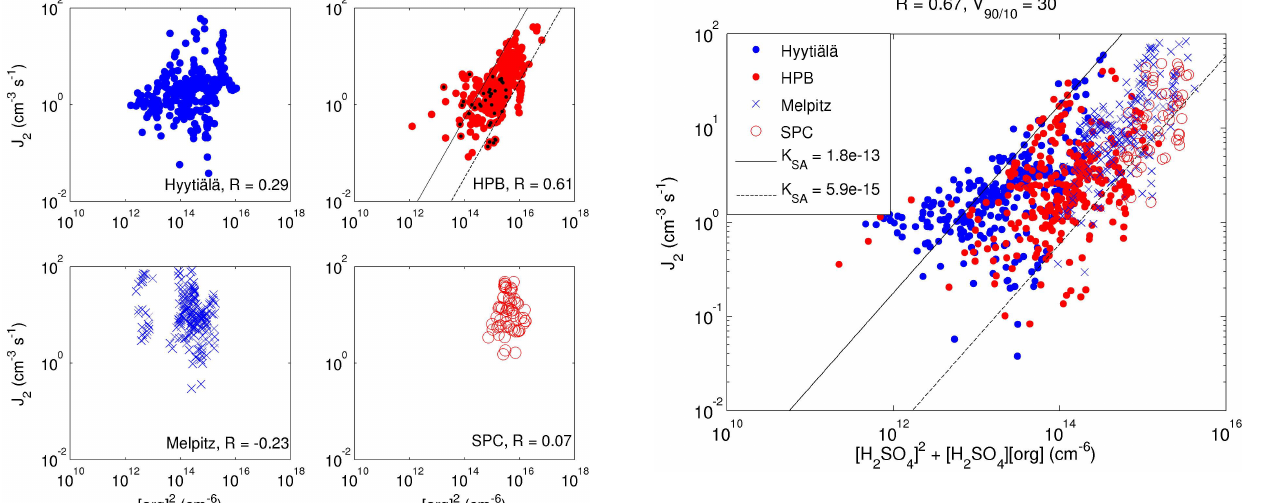
Fig. 7. Neutral particle formation rate J 2 as a function of the sum of the squared sulphuric acid concentration and the product of sul- phuric acid and organic vapour concentrations. The lines present the 90th and 10th percentile values of the coefficient K SA (Eq. 16), the values of which are presented in units (cm 3 s − 1